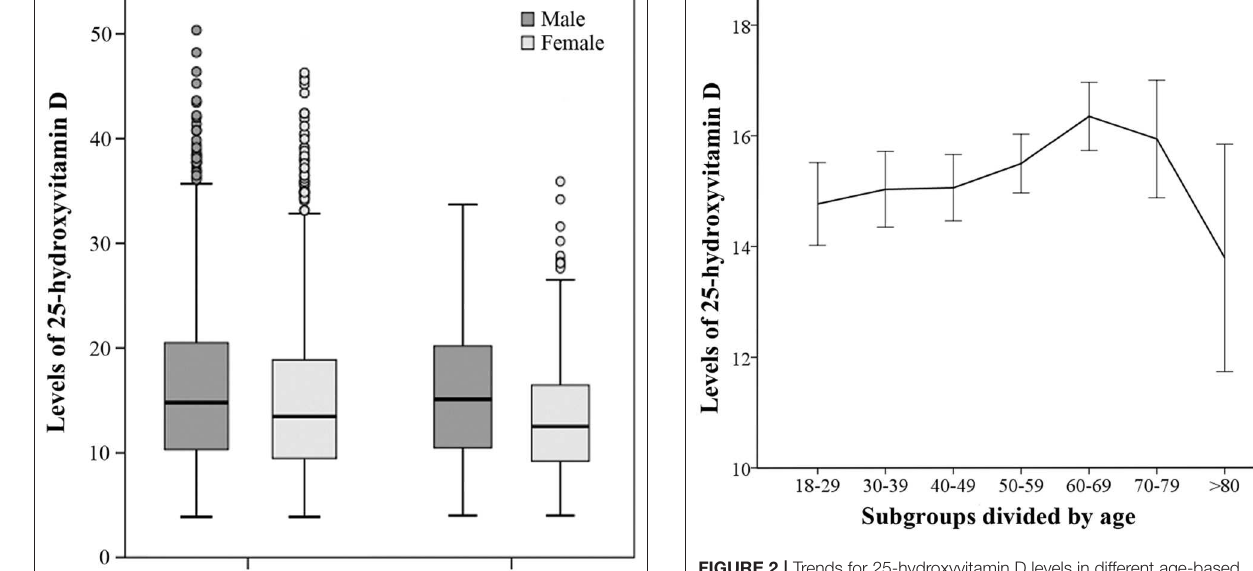
FIGURE 2 | Trends for 25-hydroxyvitamin D levels in different age-based subgroups for control group. The median 25(OH)D levels in the age-based subgroups are indicated and error bars show 95% confidence interval.